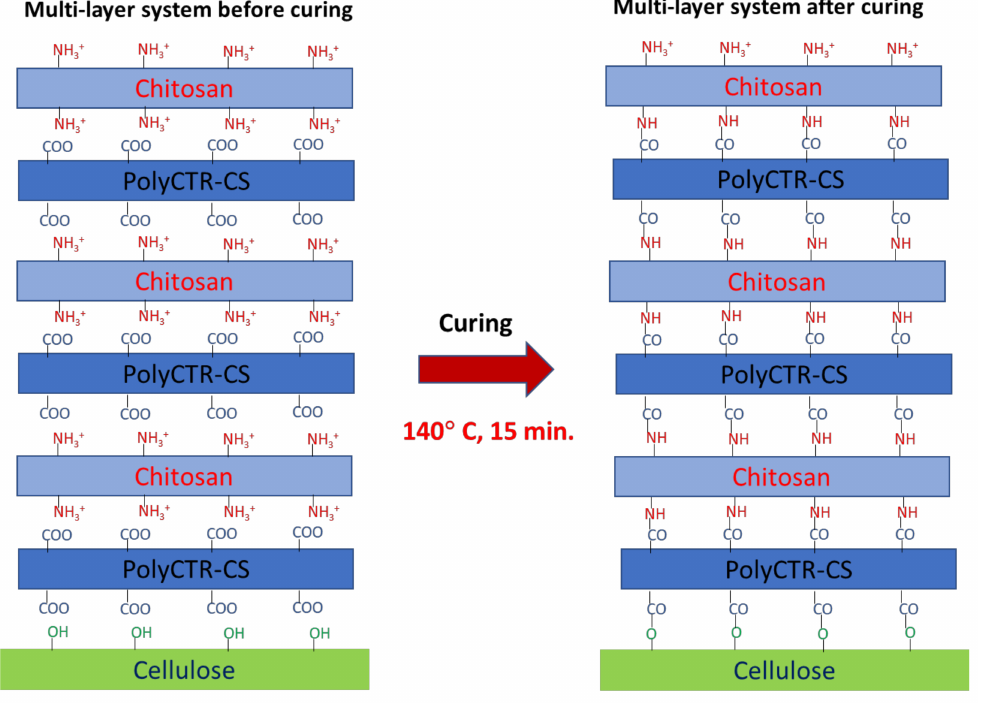
Figure 1. Scheme of the formation of ester and amide bonds within the PEM system of the concepted natural bio-sorbent after curing at 140 ◦ C for 15